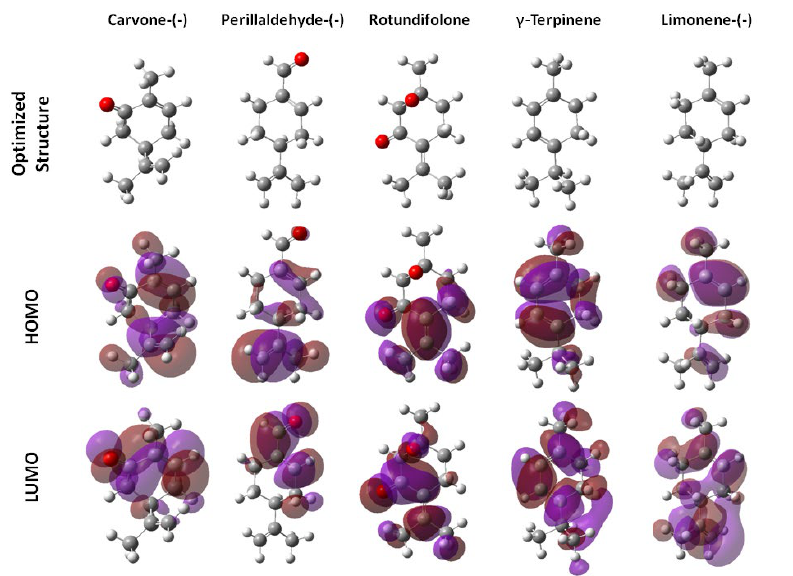
Figure 3. Molecular systems optimized calculated by DFT B3LYP/6-311G** level at theory and mapping of the frontier orbitals obtained by HF 6-311G**.